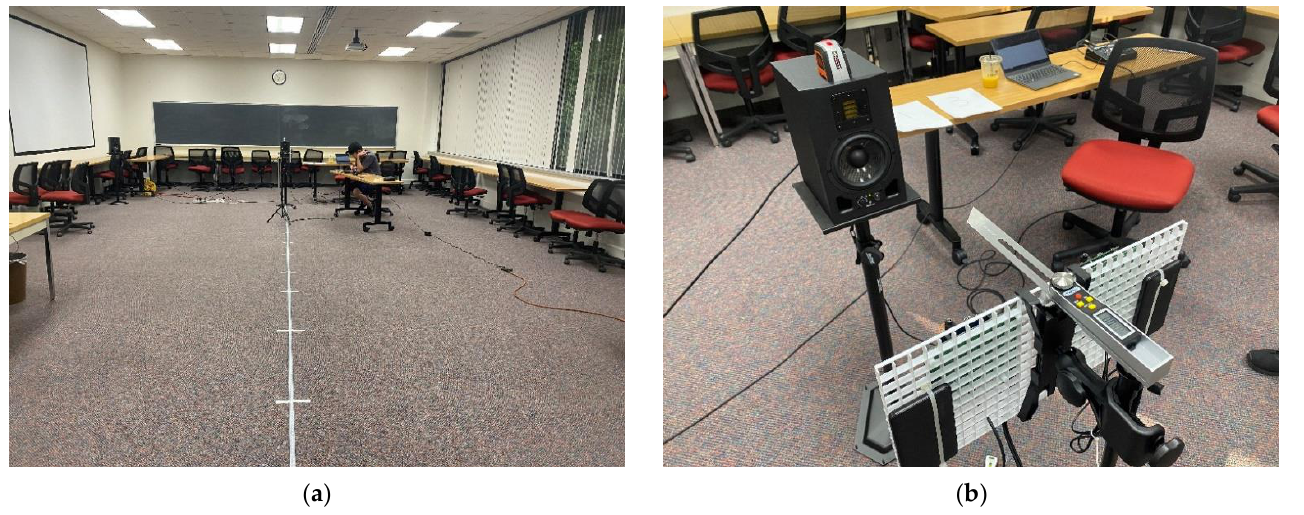
Figure 19. Acoustic performance experiment configuration : ( a ) Distance markers for receiver device; ( b ) Receiver device with digital protractor.